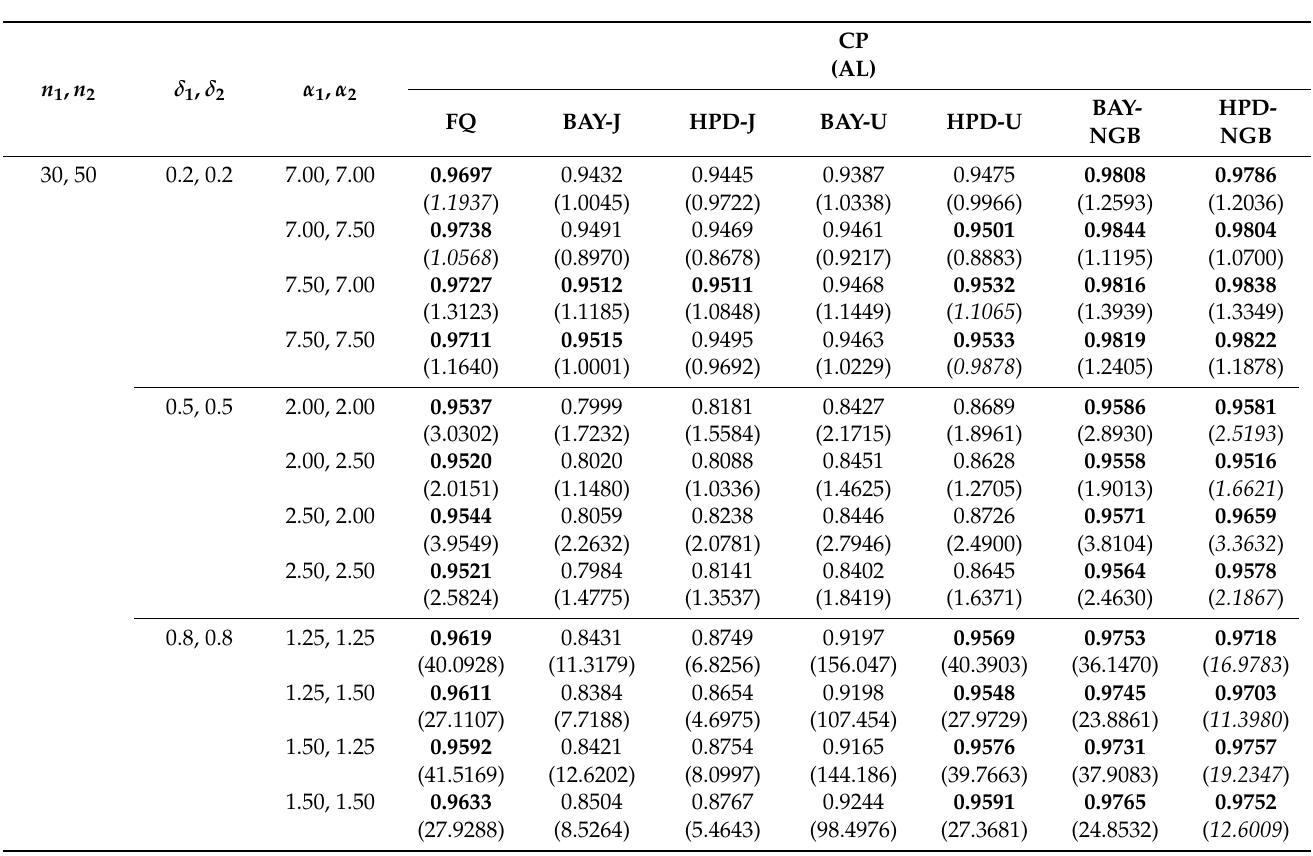
Table 2. The CPs and (ALs) of nominal 95% two-sided confidence interval for the ratio of variances of delta-gamma distributions ( n 1 (cid:54) = n 2 )